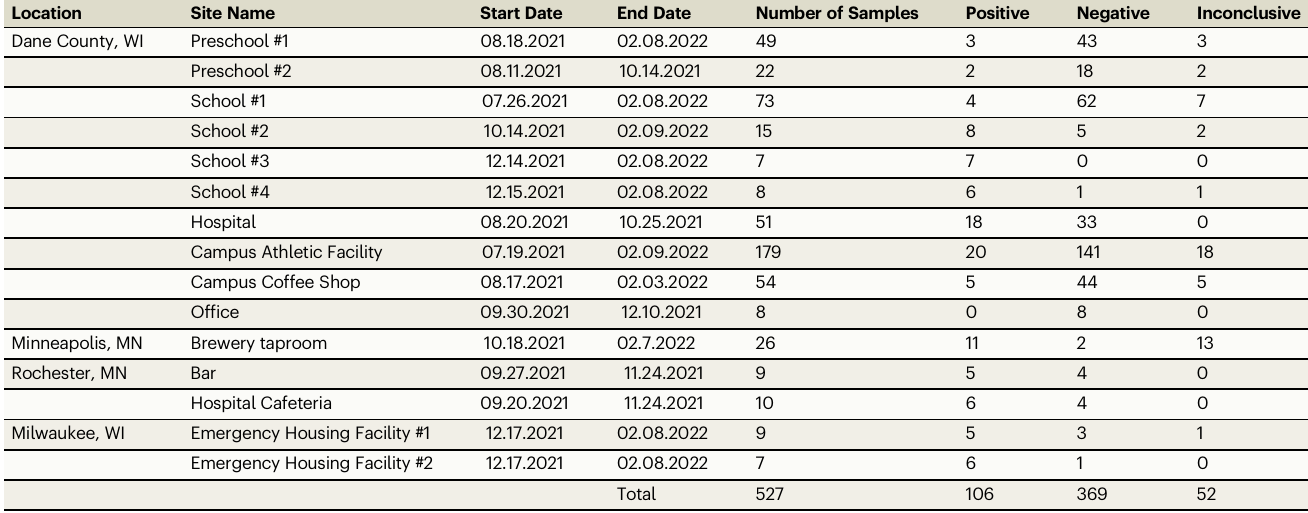
Table 1 | SARS-CoV-2 air sample